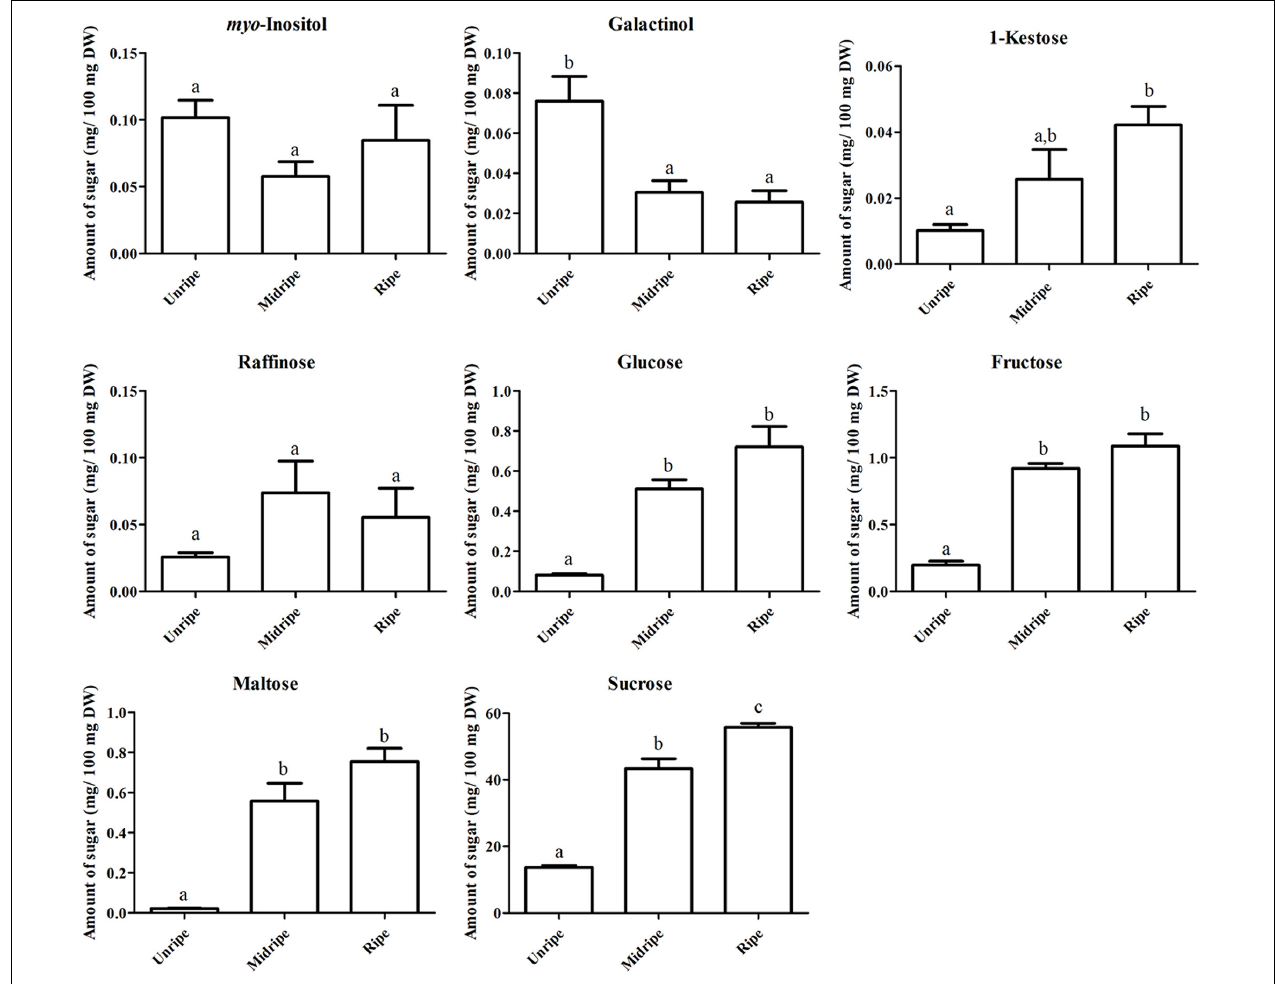
FIGURE 3 | Soluble sugar content based on dry weight, including myo-inositol, galactinol, 1-kestose, raffinose, glucose, fructose, maltose, and sucrose contents (mg/100 mg dry weight [DW]) of the durian pulp at three ripening stages (including unripe, midripe, and ripe). Each bar indicates mean ± standard error ( ± SEM) values from triplicate experiments and significant difference between stages is denoted by lower case